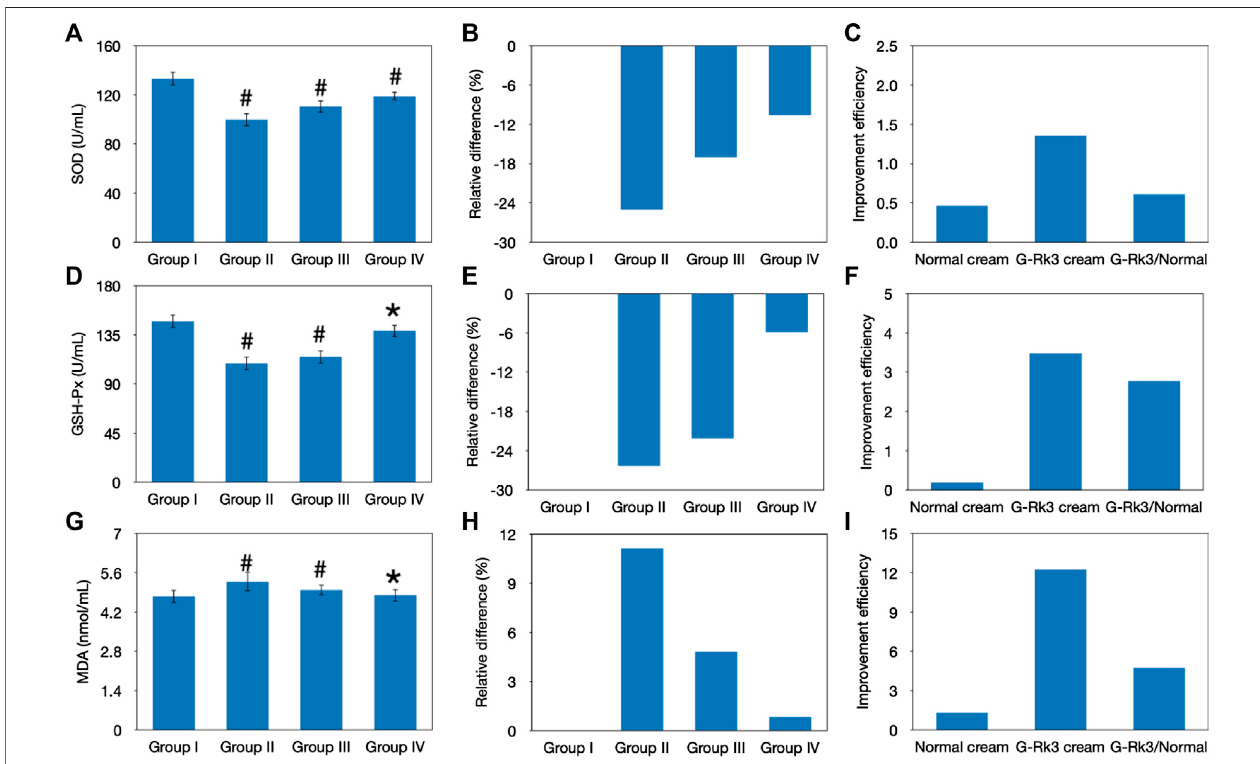
FIGURE6| Evaluationoflipidperoxidation.ChangesintheSODactivity (A – C) ,GSH-Pxactivity (D – F) ,andMDAconcentration (G – I) .Theabsolutevalue (A,D,G) . #Signi fi cantly different from group I, p < 0.05. *Not different from group I, p > 0.05. Relative differences in the four groups (B, E, H) . Improvement ef fi ciencies of normal and G-Rk3 creams (C, F, I)